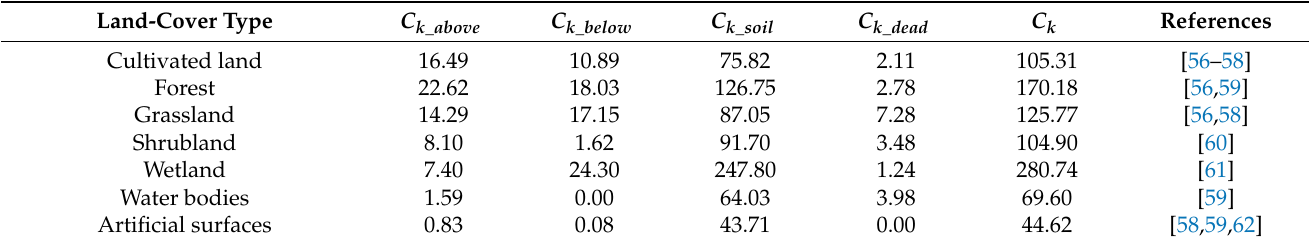
Table 6. Carbon density of each land-cover type (unit: t/hm 2